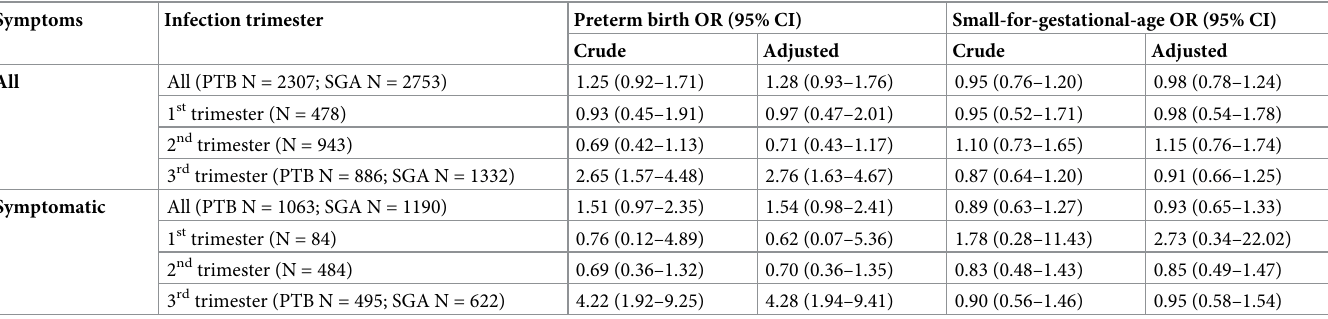
Table 3. Odds ratios of preterm birth and small-for-gestational-age among infected vs non-infected women.